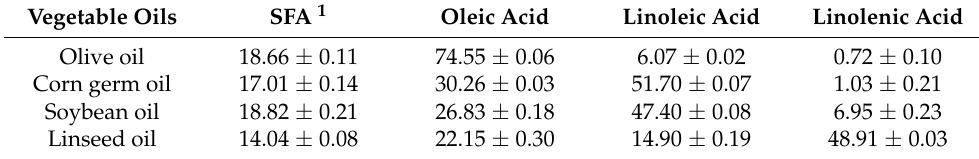
Table 3. Fatty acid composition of four vegetable oils (%; mean values ± SD, n =